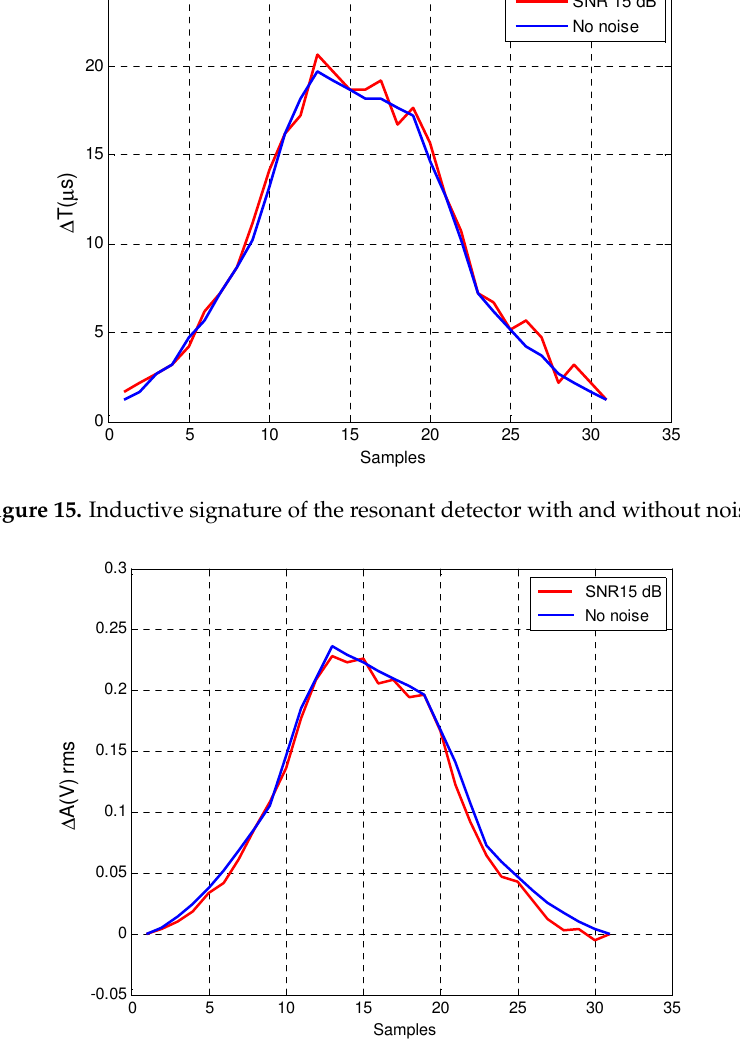
Figure 16. Inductive signature of the root mean square (rms) amplitude detector with and without